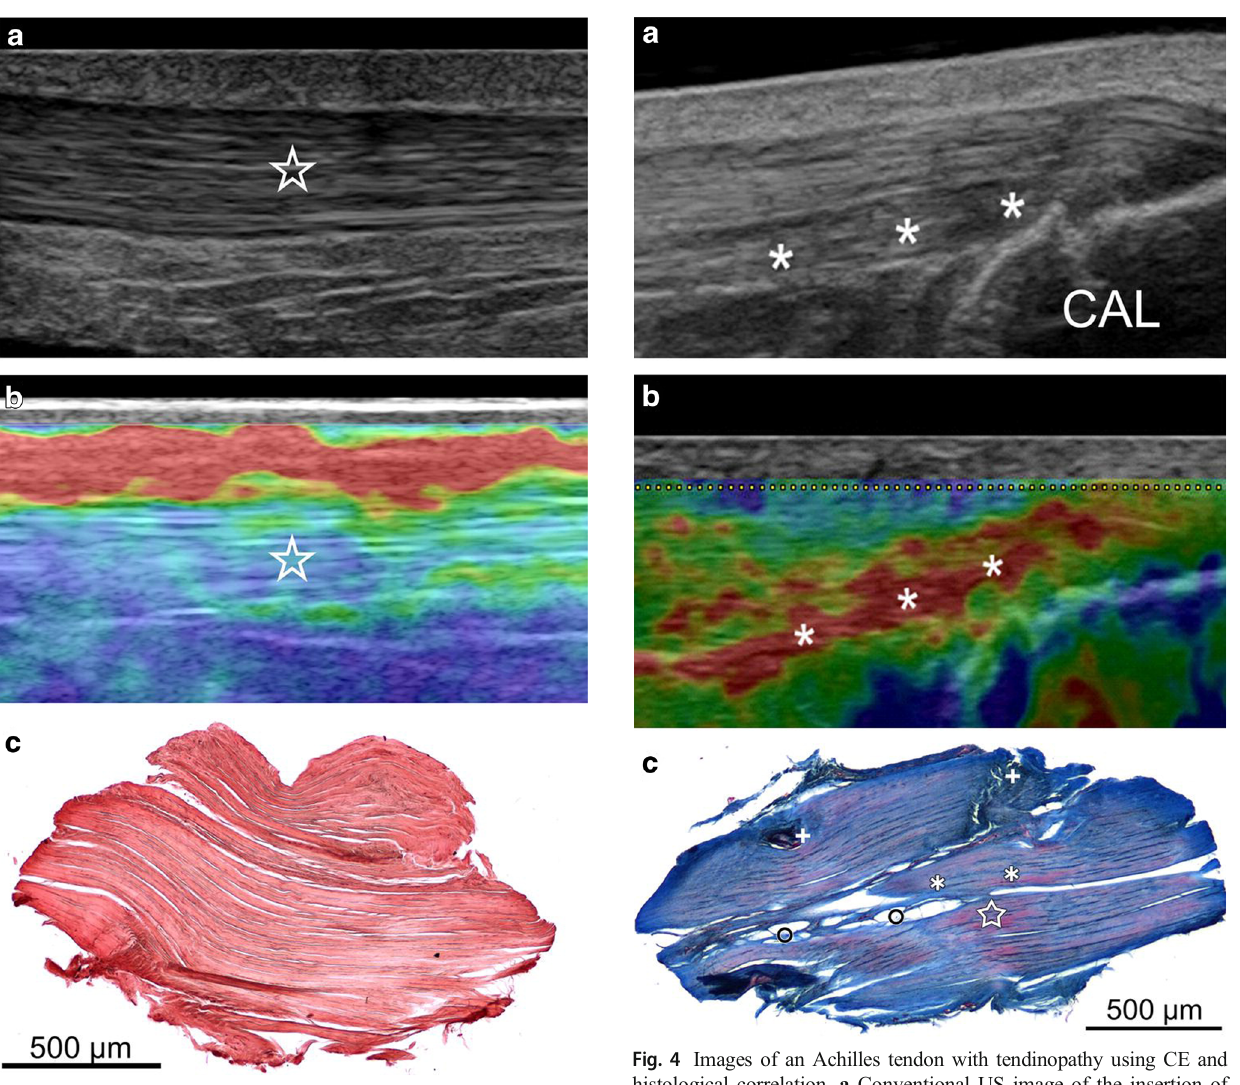
Fig. 3 Images of a normal Achilles tendon using CE and histological correlation. a Conventional ultrasound (US) image of the middle portion of the Achilles tendon in the longitudinal plane. The star indicates the homogenous fibrillar pattern defining normal tendon appearance. b Image of ultrasound elastography (USE) at the same level as in a . The blue-green area of the elastogram represented by the star indicates tissue stiffness where biopsy was subsequently performed. c Histological image obtained with orcein staining showing parallel collagen fibrils, without adipose infiltration and capillary proliferation. Reproduced, with permission, from Klauser et al. [31], copyright (2013) by the Radiological Society of North America, Inc. (RSNA)